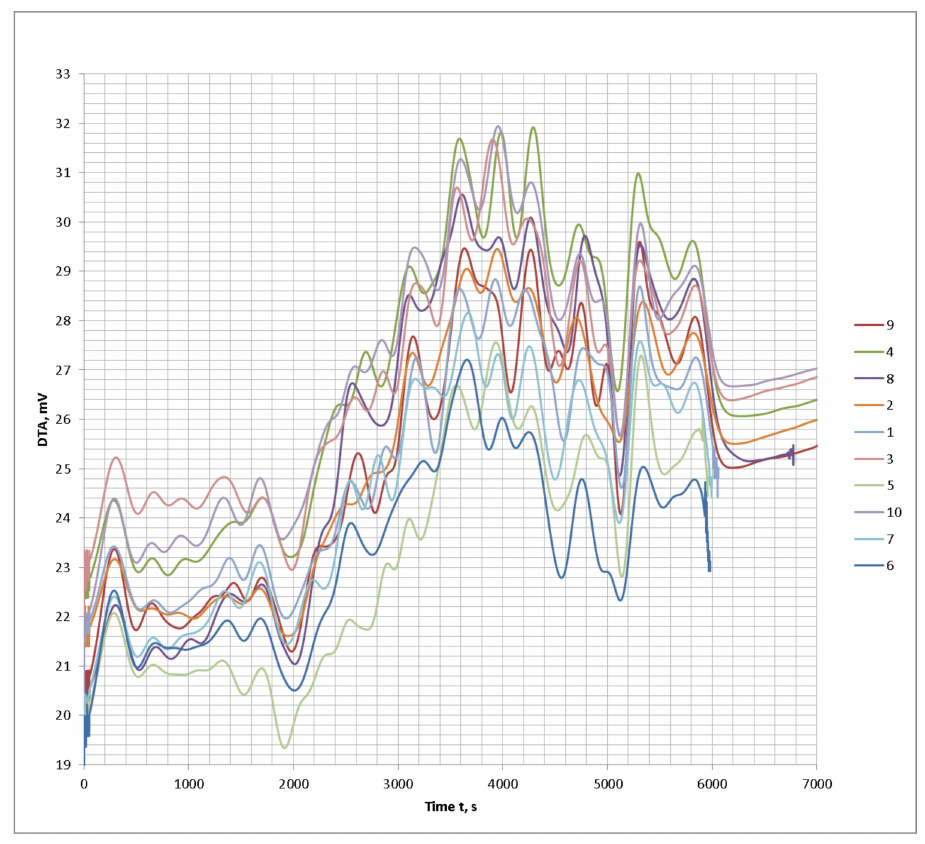
Figure 3. DTA thermograms of the tested ammonium polyphosphate (PFA) samples of the di ff erent